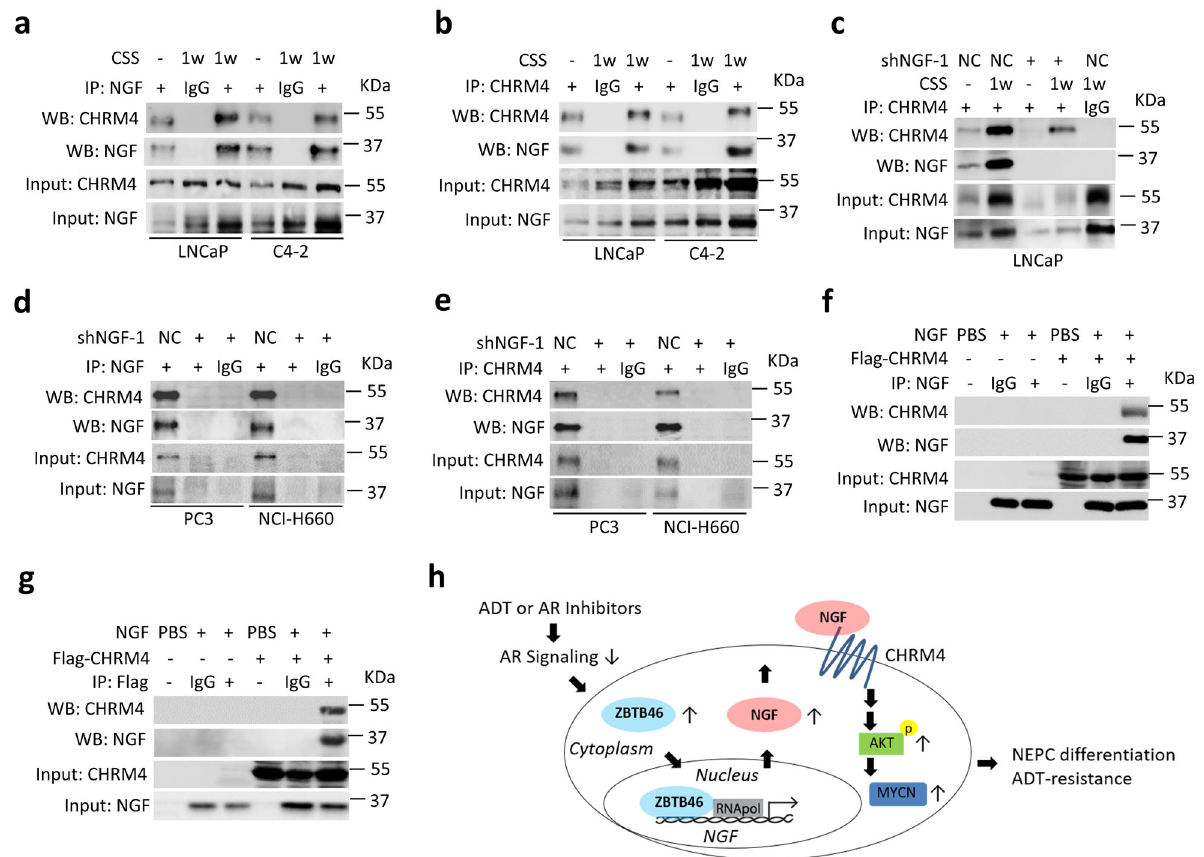
Fig. 7 The NGF interacts with CHRM4. a Immunoprecipitation (IP) of the NGF and Western blotting of CHRM4 and the NGF in LNCaP and C4-2 cells cultured in charcoal stripped serum (CSS)-containing medium for 1 week. b IP of CHRM4 and Western blotting of CHRM4 and the NGF in LNCaP and C4-2 cells cultured in CSS-containing medium for 1 week. c IP of CHRM4 and Western blotting of CHRM4 and the NGF in LNCaP cells following stable NGF- knockdown and culturing in CSS-containing medium for 1 week. d IP of the NGF and Western blotting of CHRM4 and the NGF in PC3 and NCI-H660 cells stably expressing a non-target control (NC) or NGF shRNA vector. e IP of CHRM4 and Western blotting of CHRM4 and the NGF in PC3 and NCI-H660 cells stably expressing the NC or NGF shRNA vector. f , g IP of the NGF f or Flag g and Western blotting of CHRM4 and the NGF in a mixture of recombinant NGF protein and in vitro transcription/translation synthesized Flag-CHRM4 protein. h Proposed model of ADT or AR inhibitor-mediated therapeutic resistance and neuroendocrine differentiation of prostate cancer cells by stimulation of the ZBTB46 transcription factor, which upregulates the NGF. The upregulated NGF promotes ADT-resistance and NEPC development by integrating CHRM4 and activating the AKT – MYCN